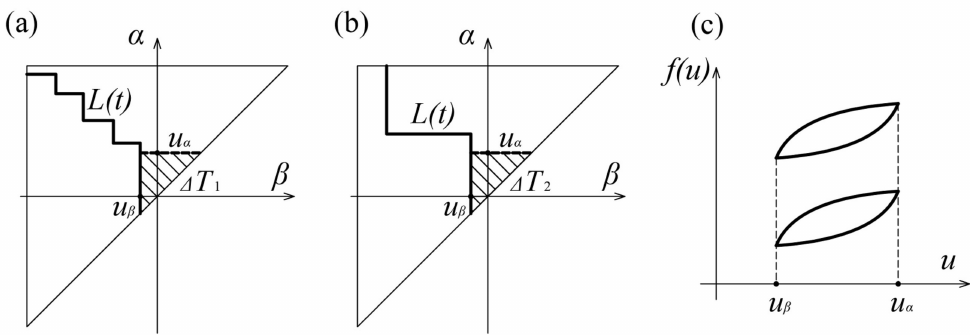
Figure 8. The congruency property of the Preisach model: ( a ) α – β diagrams for thr input u 1 ; ( b ) α – β diagrams for thr input u 2 ; ( c ) The coincidence for loops for input u 1 and u 2